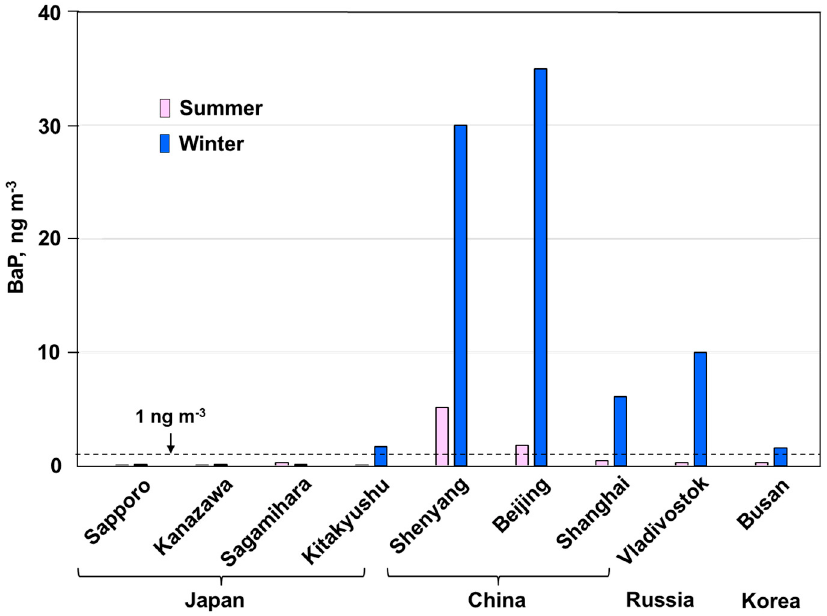
Figure 7. Benzo[ a ]pyrene (BaP) concentrations in Far Eastern Asian cities.